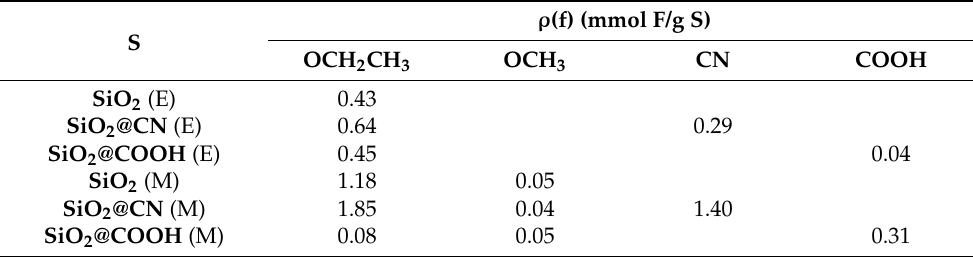
Table 2. Number of functions (F) (mmol) per g sample, calculated by 1 H NMR.